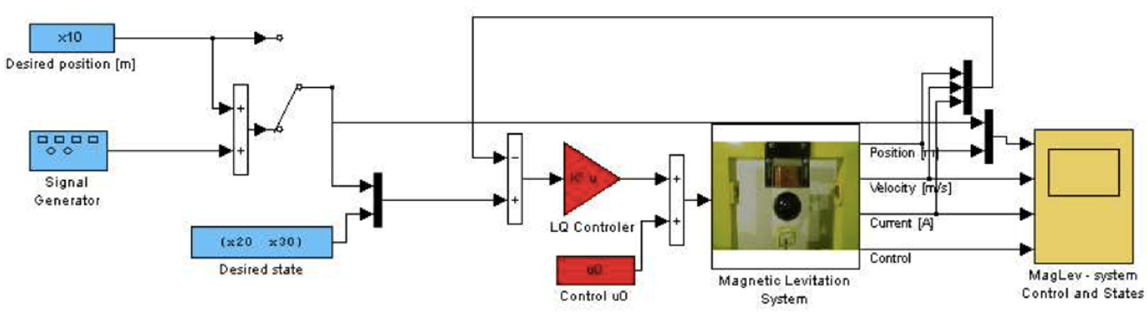
Figure 5. LQ tracking control diagram in Simulink environment.